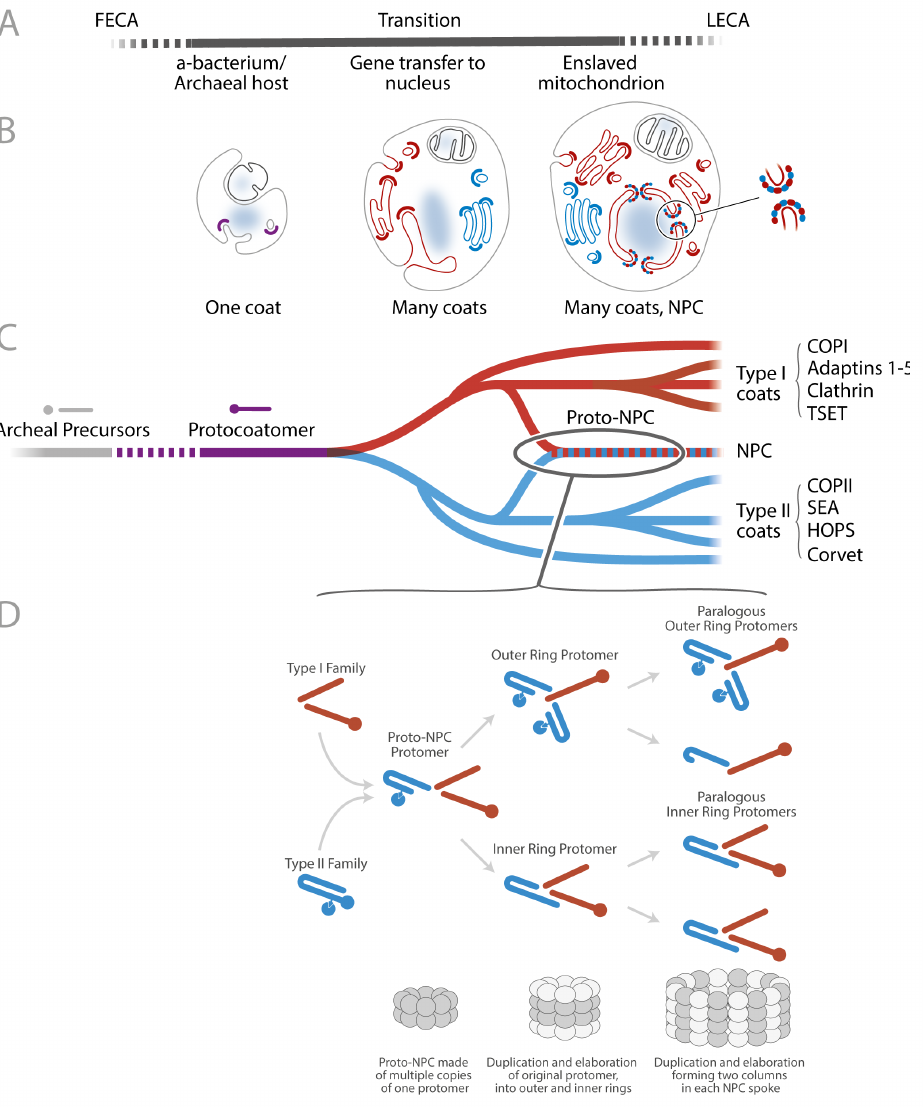
Figure 3. Timeline for evolution of coat complexes, mitochondrial enslavement, and nuclear pore complex (NPC) elaboration. ( A ) The top system illustrates acquisition and gradual enslavement of the mitochondrion by transfer of genes from the original bacterial genome to the genome of the host cell. Dotted lines indicate uncertainty concerning both the point of endosymbiont acquisition and duration of the overall process. ( B ) The top middle system depicts hypothetical general structures of transitional eukaryotic cellular forms at various stages during the process of eukaryogenesis. The location and type of protocoatomer are indicated by colored crescents. Note the amalgam coat of the NPC. ( C ) The lower middle system is a proposed timeline for the evolution of vesicular coat complexes, colored to correspond with the cellular diagrams. The earliest proto-eukaryote is suggested to have a single ancestral coat (protocoatomer), which is derived from Archaeal genes. In many prokaryotes, such genes are present, but the β -propellers and α -solenoids are not fused to encode a single protein. Examples of type I and type II architectures are shown at the right, together with examples of specific complexes present in modern eukaryotes. ( D ) The lower system illustrates a possible route for the evolution of the NPC, placing emphasis on the duplication of subunits and merging of protocoatomer type I and type II to create the modern NPC structure. Ovals represent subunits in the evolving NPC and are differently shaded to indicate duplications. Type I coats are red, type II are blue, and protocoatomer is purple. Putative archaeal lineages and proteins are shown in gray. FECA, first eukaryotic common ancestor; LECA, last eukaryotic common